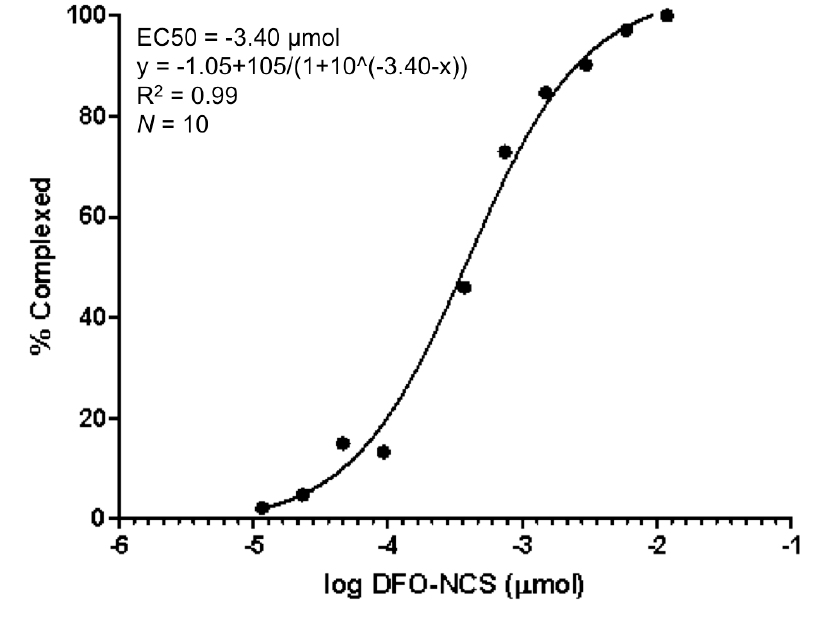
Figure S4. DFO- 89 Zr titration curve that resulted in an effective specific activity